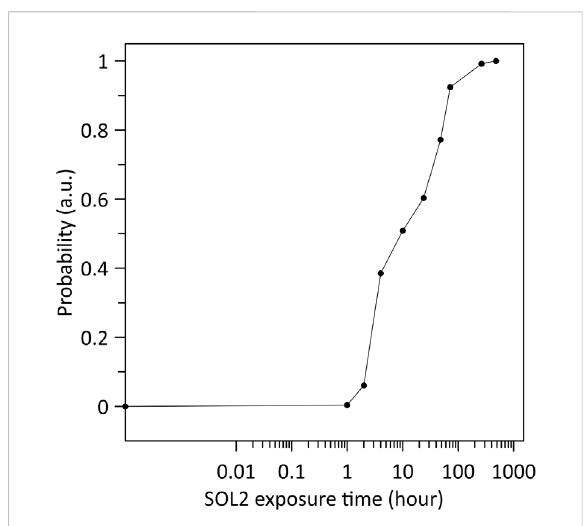
FIGURE 6 Probabilityofbleachingtimepriortosedimentation,obtained by evaluating the goodness-of- fi t of the predicted dose residuals against those from known bleaching times in Figure 5, using the reduced chi-square